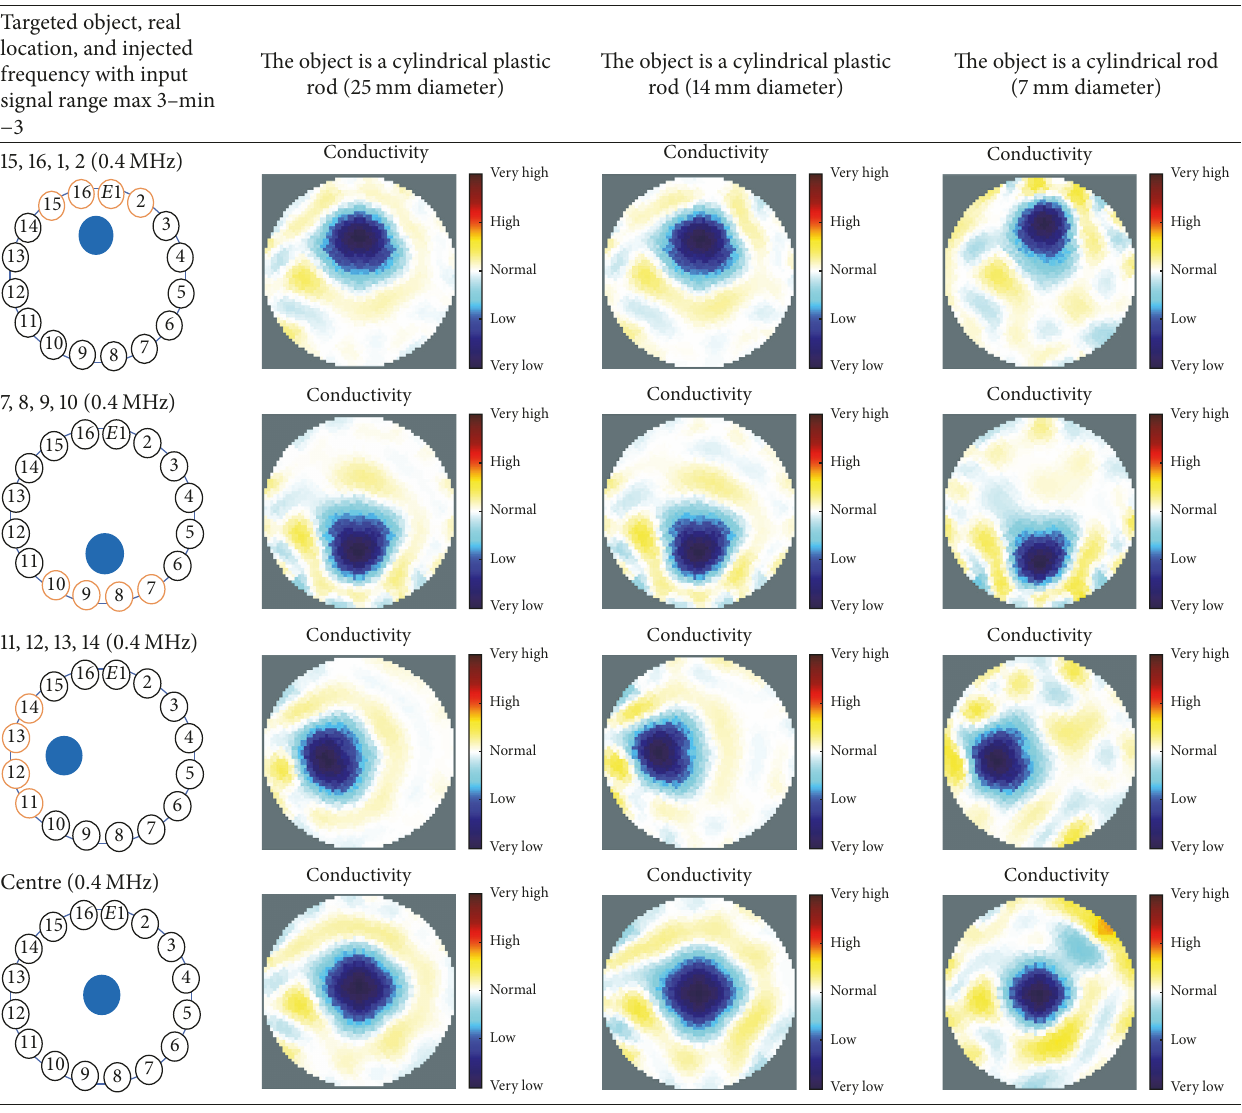
Table 3: Nonconductive objects at different positions; reconstructed images for three different nonconductive object diameters (25 mm, 14mm, and 7 mm).